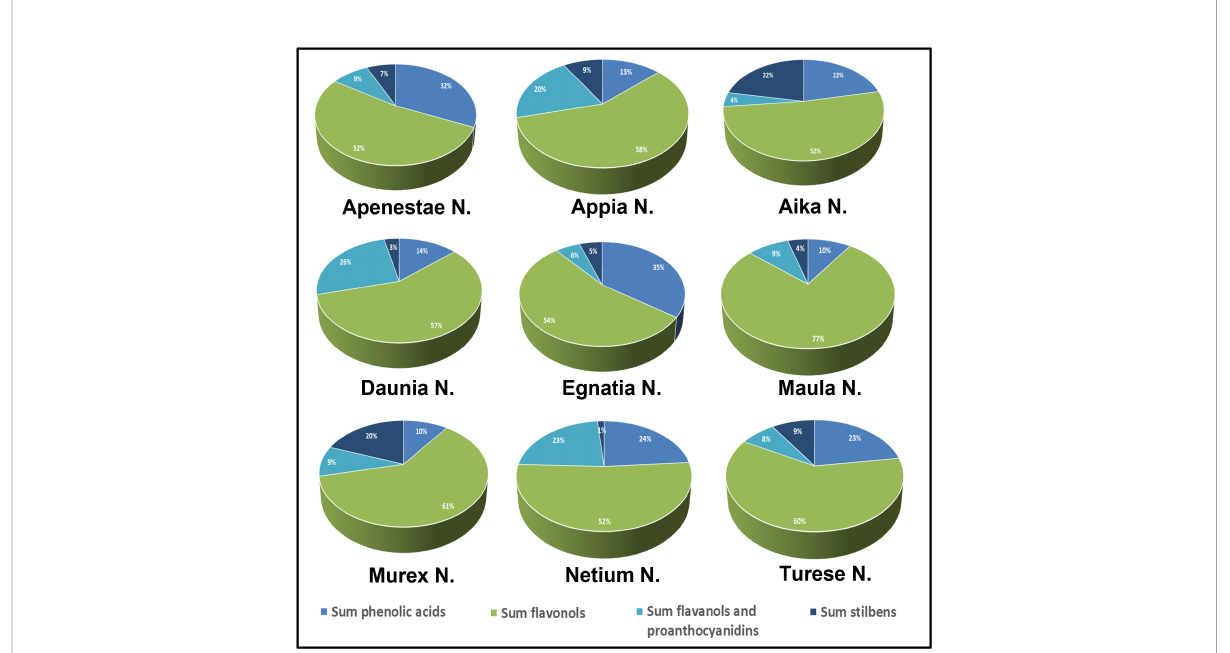
FIGURE 4 Polyphenolic composition of skin extracts of the new grape genotypes: relative percentages (%) of the single classes of compounds were expressed on the sum of [M-H] - signal intensities recorded in the negative-ionization UHPLC/QTOF